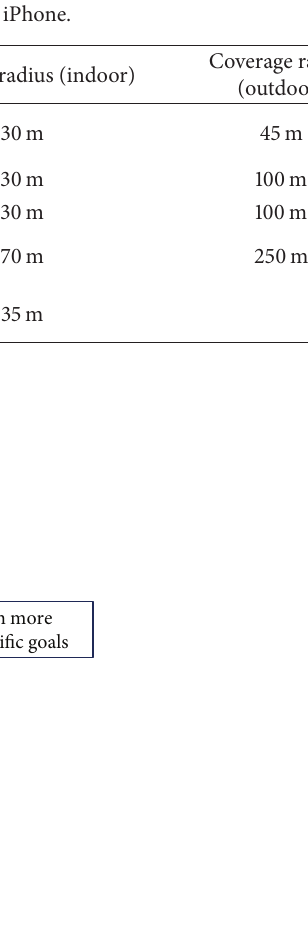
Figure 3: Emergency communication realization flow chart.